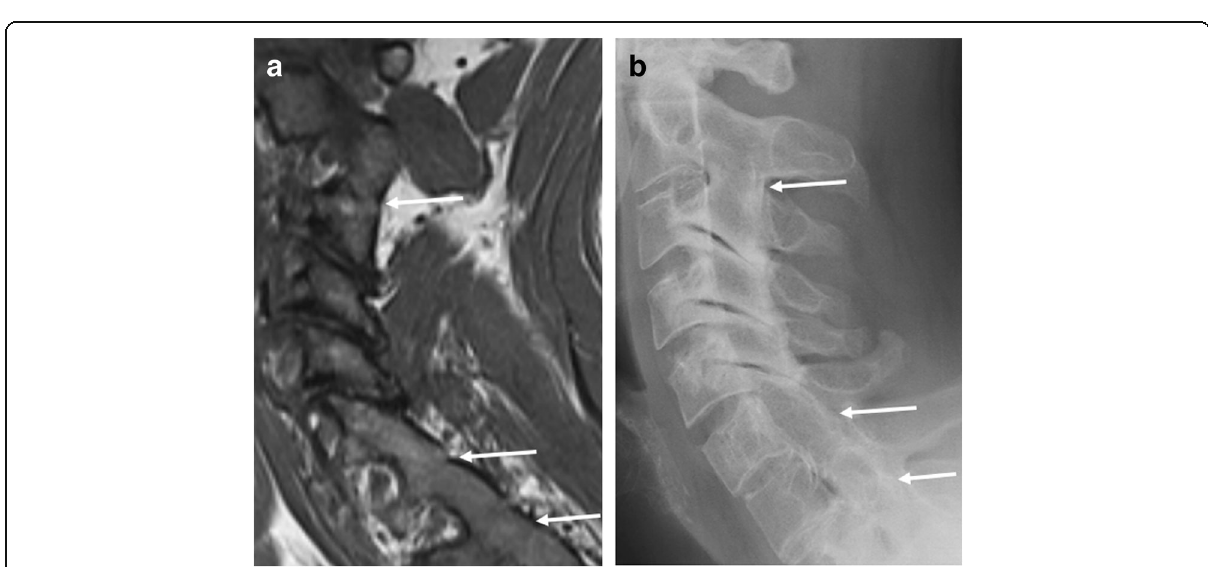
Fig. 9 Ankylosis of the facet joints. a Sagittal T1-weighted MR image acquired in a 34-year-old man with SpA shows ankylosis of the facet joints of C2-C3, C6-C7, and C7-Th1 (arrows). b Radiography of the cervical spine confirms this bony fusion of these joints